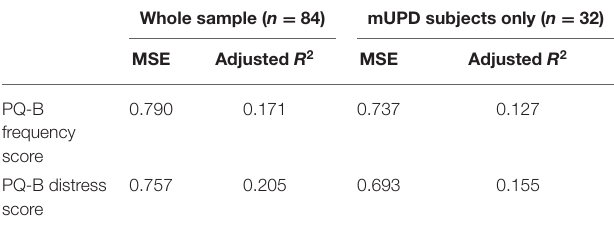
TABLE 6 | Comparison of model fit between whole sample and mUPD subjects